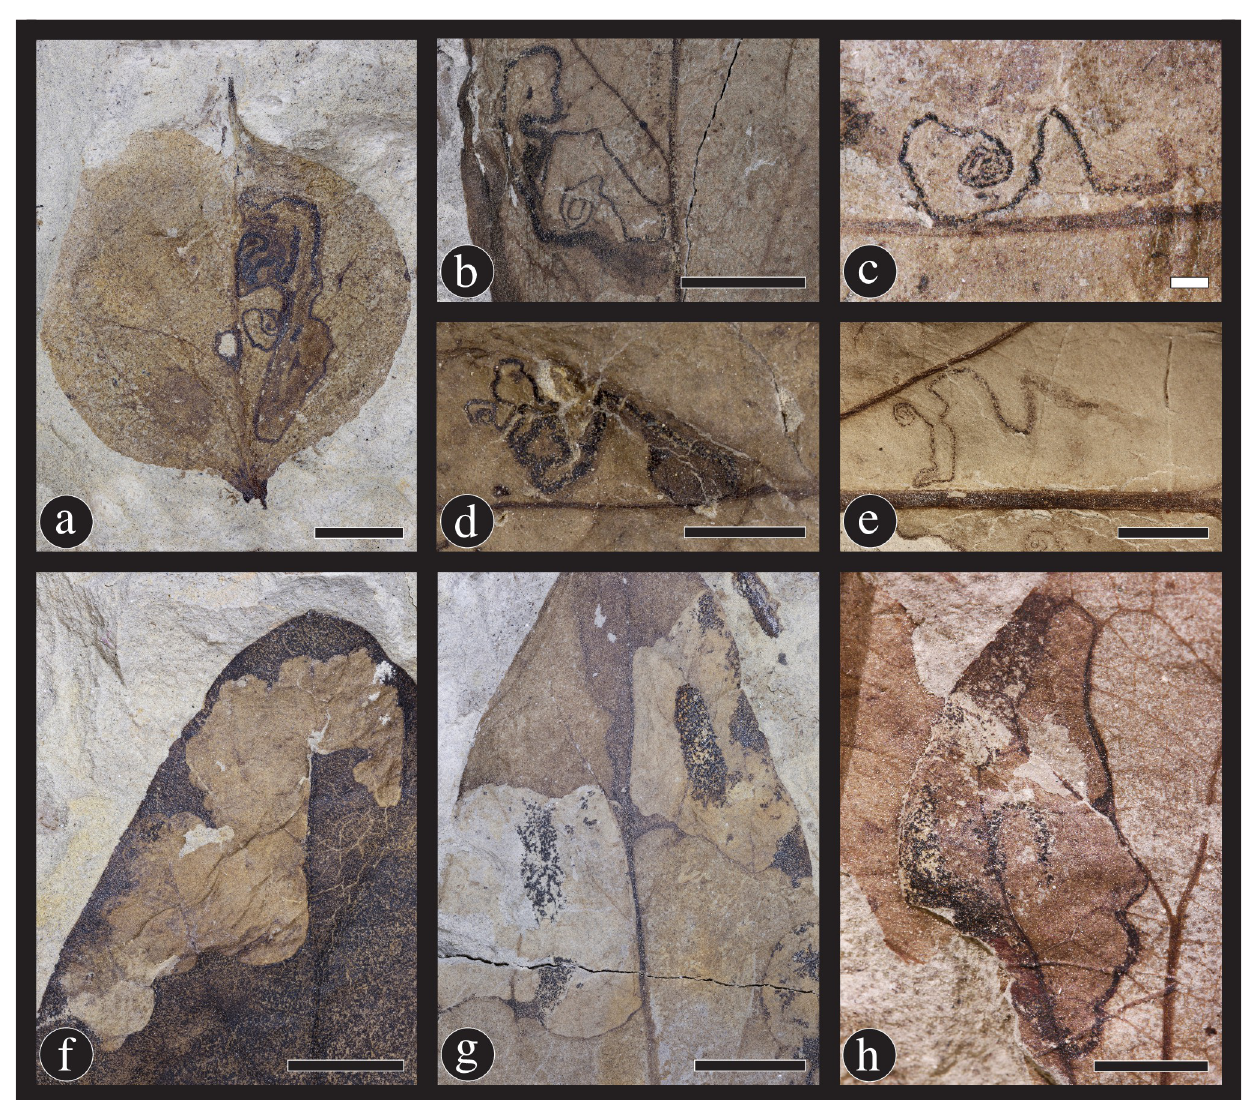
Fig 14. Mining insect damage at the Lost Valley Locality, Kaiparowits Formation, Utah. (A–E) DT45; Leaf mines attributed to the lepidopteran family Gracillariidae. These five mines illustrate the variation in overall shape, projection, and length, potentially due to the number of instars completed during the mining life history stage (A: DMNH 39732; B: DMNH 41582; C: DMNH 39735; D: DMNH 47124; E: DMNH 39733). The three types of blotch mines include: (F) DT36; A blotch mine lacking internal frass and a central chamber (DMNH 41572); (G) DT35; A blotch mine with frass present in circular central chamber (DMNH 41581); and (H) DT37; A blotch mine with an internal serpentine phase (DMNH 39734). Black scale bars = 5 mm; white scale bars = 1 mm.